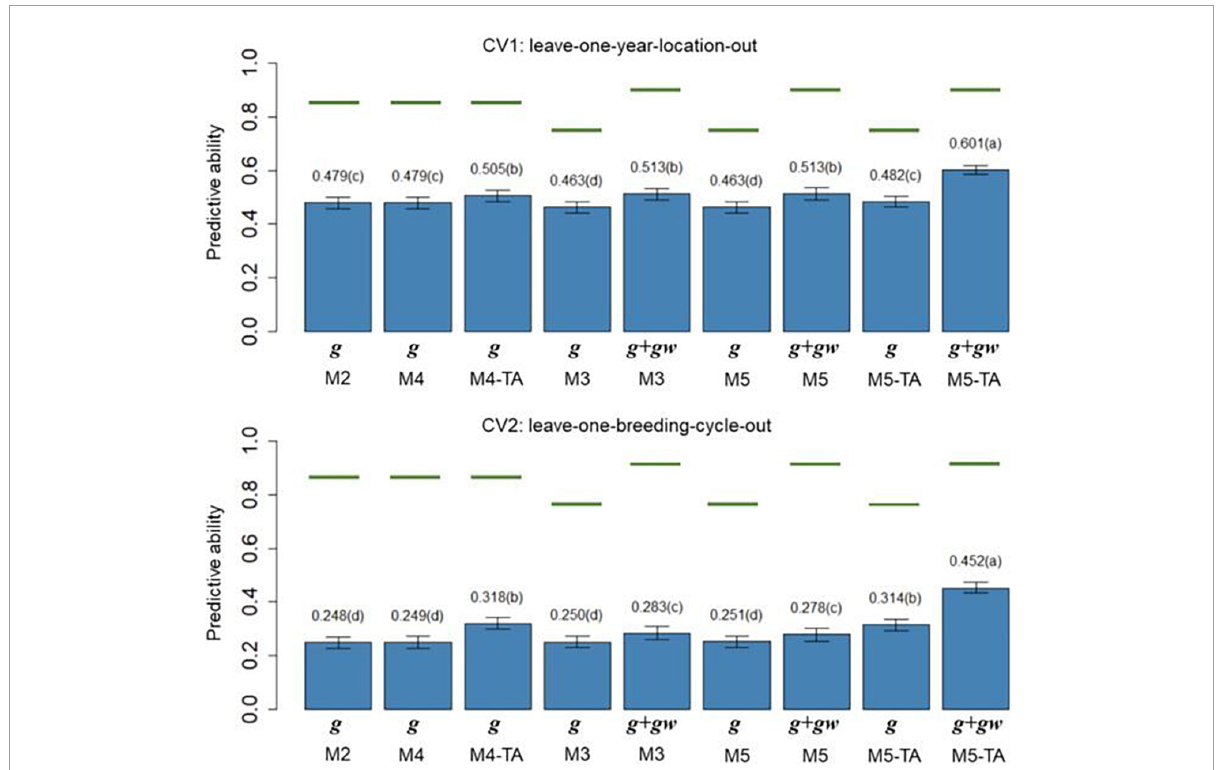
FIGURE5 Barplot of predictive abilities (PAs) for protein content in leave-one-year-location-out (CV1, upper panel ) and leave-one-breeding-cycle-out (CV2, lower panel ) cross-validations. M2: line + genomic [SNPs] additive effect + spatial effect + line × environment interaction. M3 expand M2 by adding a genomic [SNPs] additive × ECs interaction. M4 expand M2 to the multi-trait case. M4-TA is the M4 using trait-assisted (TA) genomic prediction. M5 expand M3 to the multi-trait case. M5-TA is the M4 using TA genomic prediction. Black bars are the 95% confidence interval. Differences in the letter above the bar represent significant differences between models ( P-value < 0.01). Green lines are the theoretical maximum PAs.